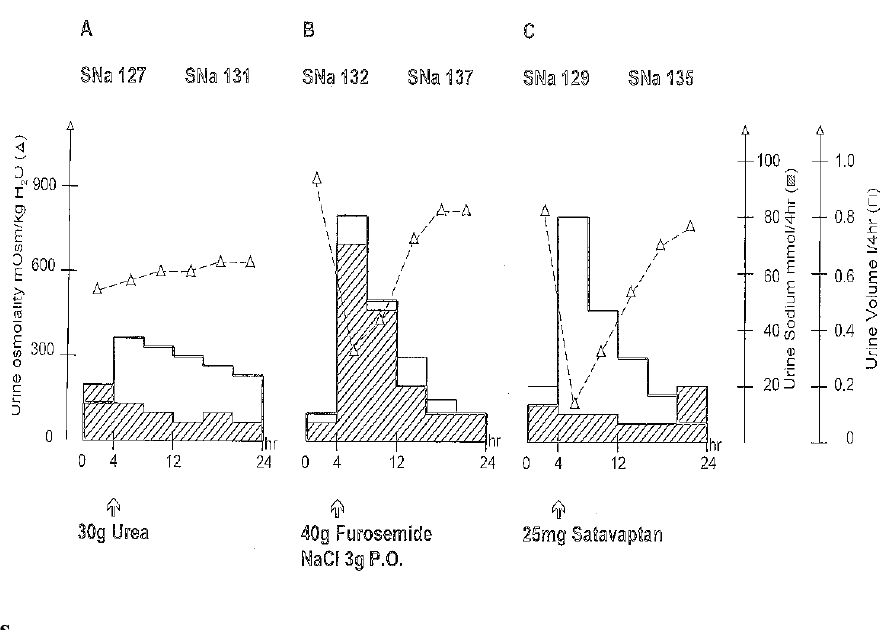
Figure 2. Evolution of diuresis, urine osmolality and urine sodium in three patients with urea, furosemide or V 2 antagonist (satavaptan) (data adapted form References